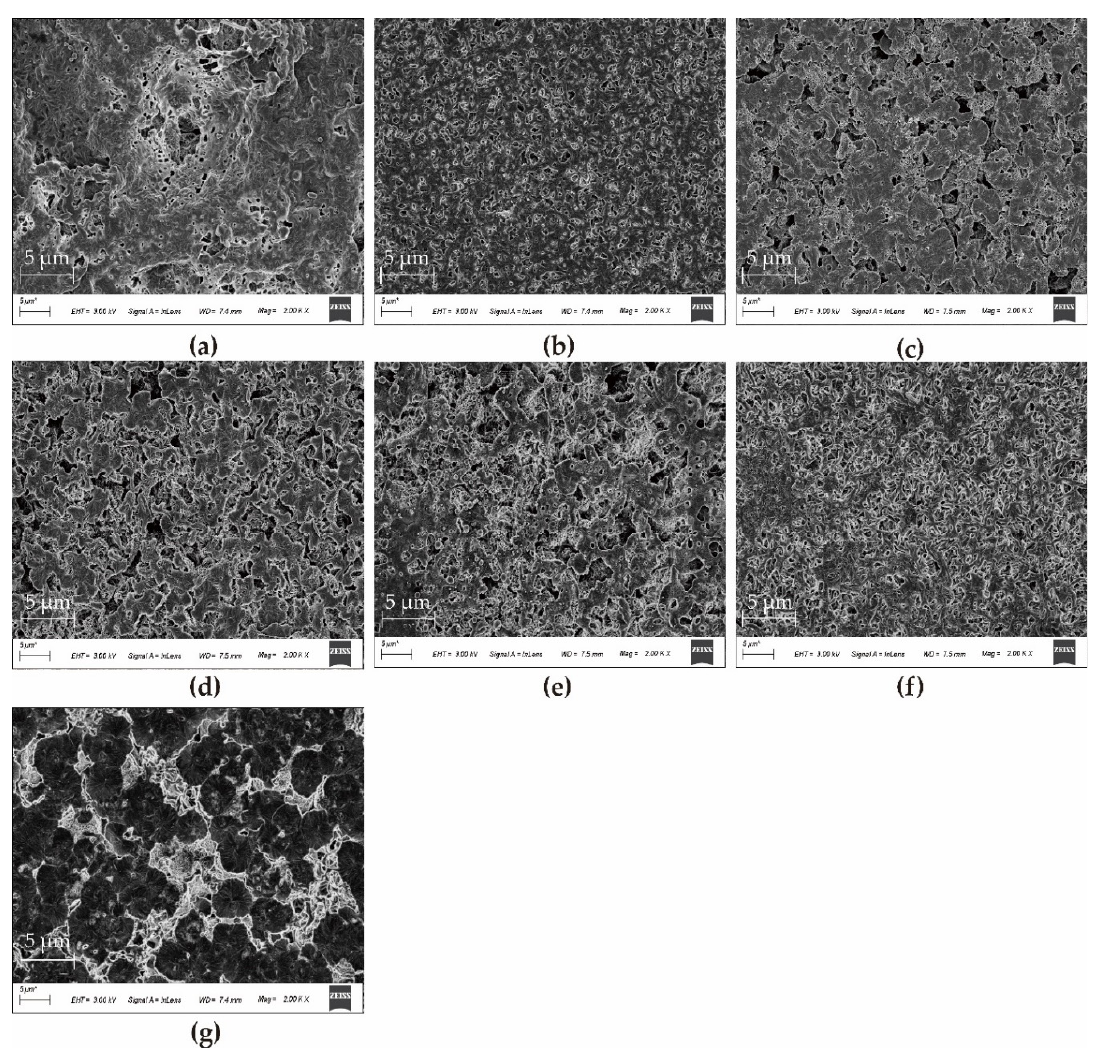
Figure 8. SEM images of upper surfaces of various PA66 membranes: ( a ) P0, ( b ) P1, ( c ) P2, ( d ) P3, € P4, ( f ) P5, and ( g ) P6.